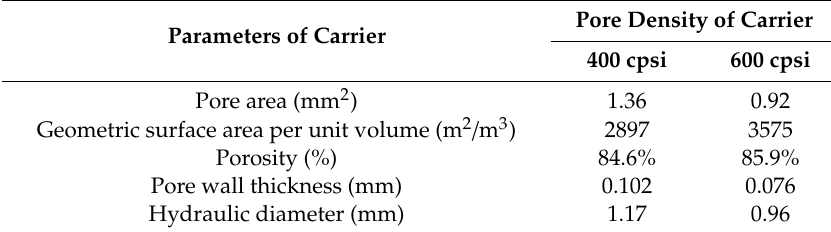
Table 7. Comparison of carrier parameters of 1# and